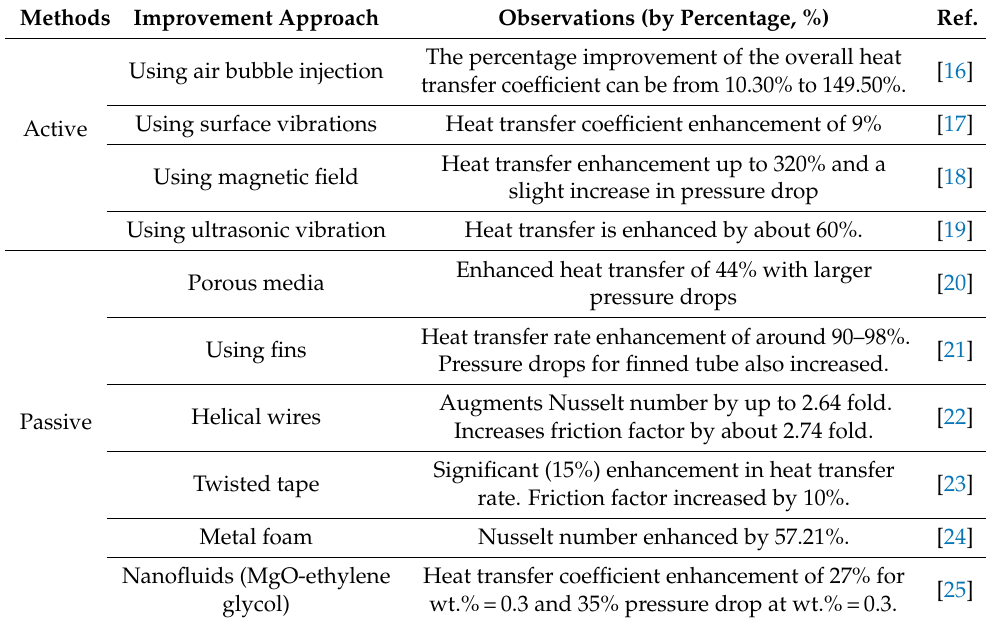
Table 1. Examples of methods used to improve the double-pipe heat exchanger. Methods Improvement Approach Observations (by Percentage, %)